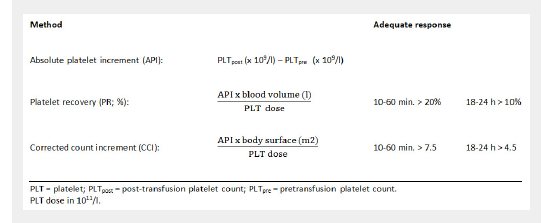
Methods for assessment of platelet transfusion efficacy.